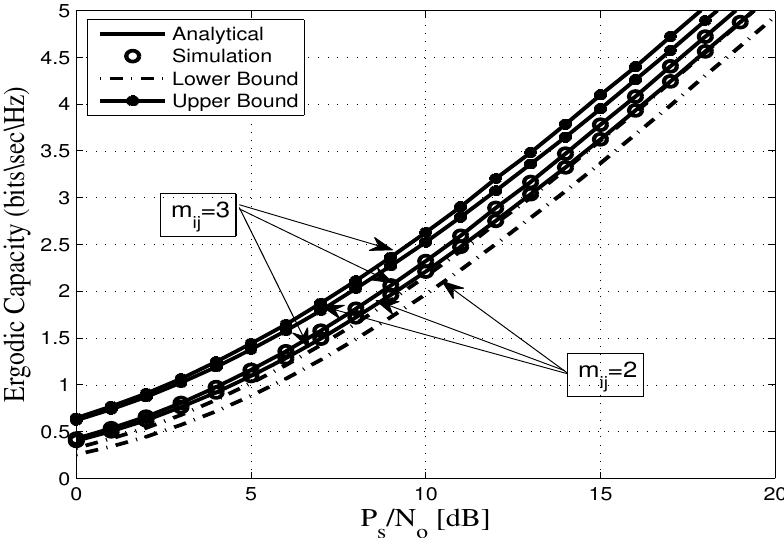
Figure 7. Ergodic capacity vs. P S / N o for different values of m ij with γ RR = 5 dB, γ ID = 10 dB, d SR = 0.45, d RD = 0.55, and η =